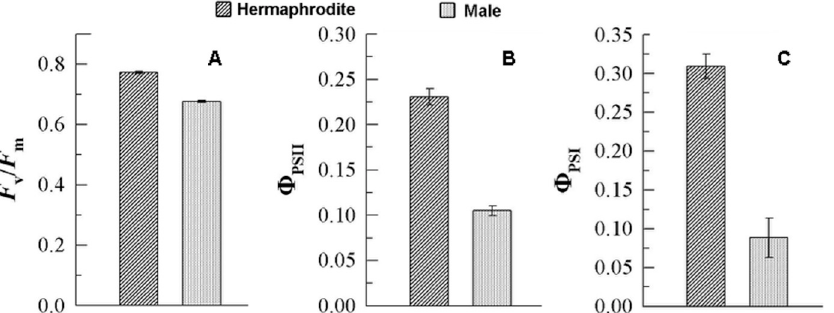
Fig 3. Photosynthetic efficiency of C . thalictroides gametophytes. (A) The activity of the chlorophyll fluorescence parameter (Fv / Fm); (B) the activity of photosystem Ⅱ ( Ф PS Ⅱ ); (C) the activity of photosystem Ⅰ ( Ф PS Ⅰ ). Error bars indicate standard errors of three biological